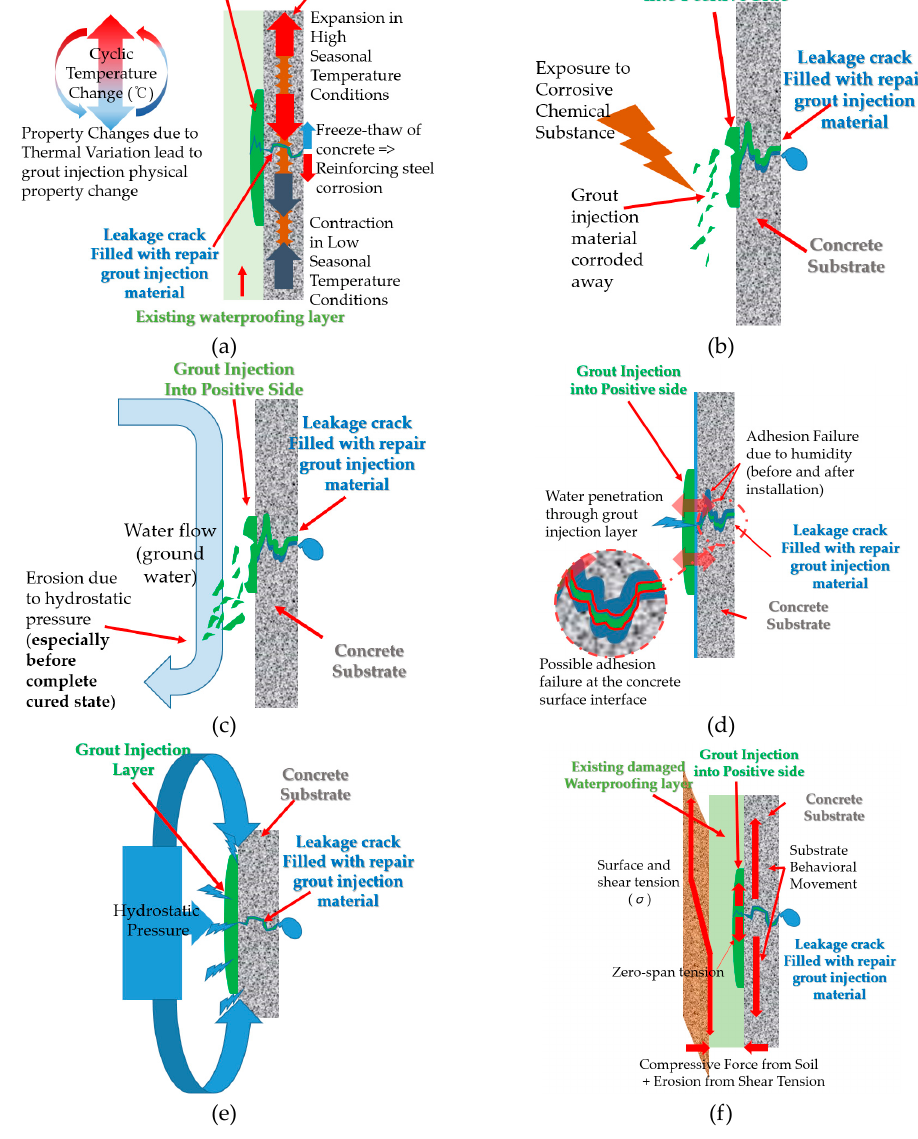
Figure 2. The six types of expected degradation conditions in the below-grade environment; ( a ) the cyclic thermal stress on concrete and waterproofing membrane, ( b ) a chemical attack on the waterproofing, ( c ) erosion due to hydrostatic pressure or water flow, ( d ) a membrane wet surface due to humidity, ( e ) hydrostatic pressure damage to the waterproofing membrane, and ( f ) the zero-span tension and shear stress applied on a waterproofing membrane.